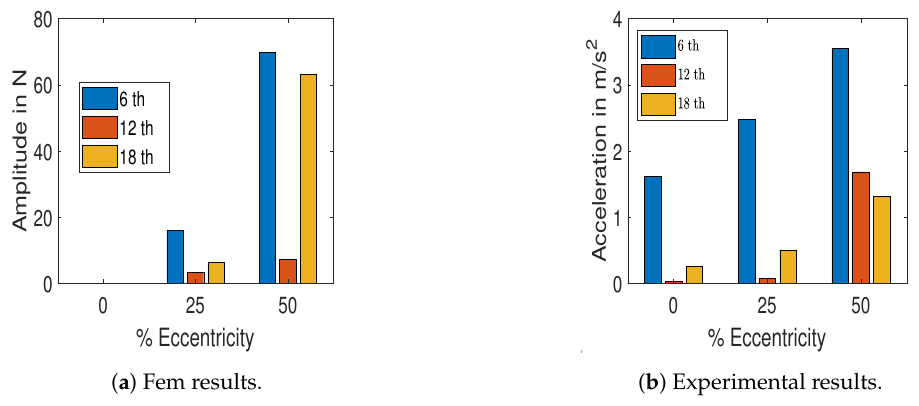
Figure 17. Force and acceleration vs. eccentricity